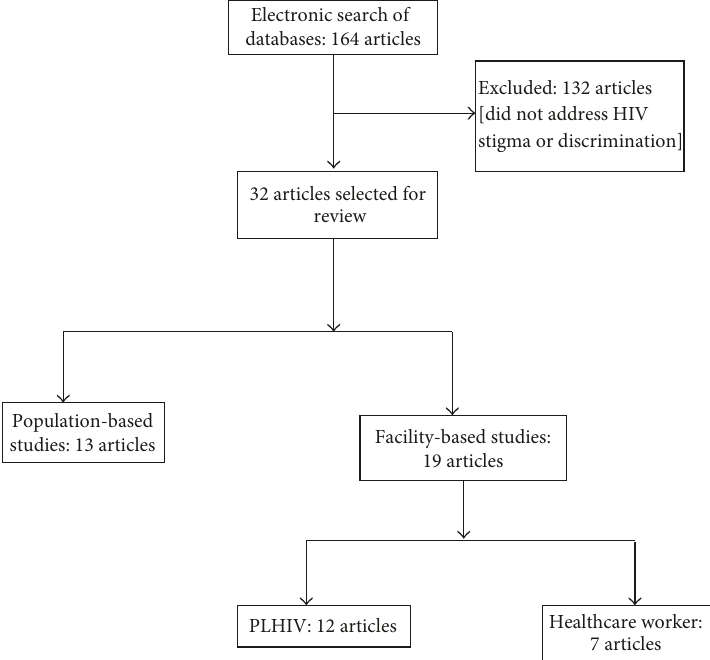
Figure 1: Flow chart of articles selected for